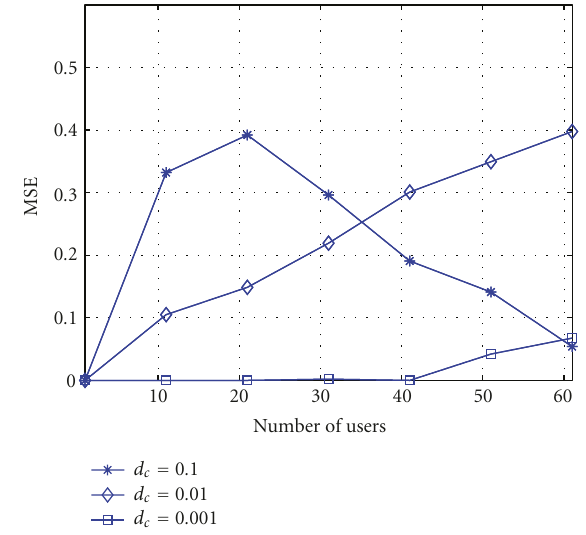
Figure 5: Simulation results: the mean square error of estimated covariance matrix by standard estimation